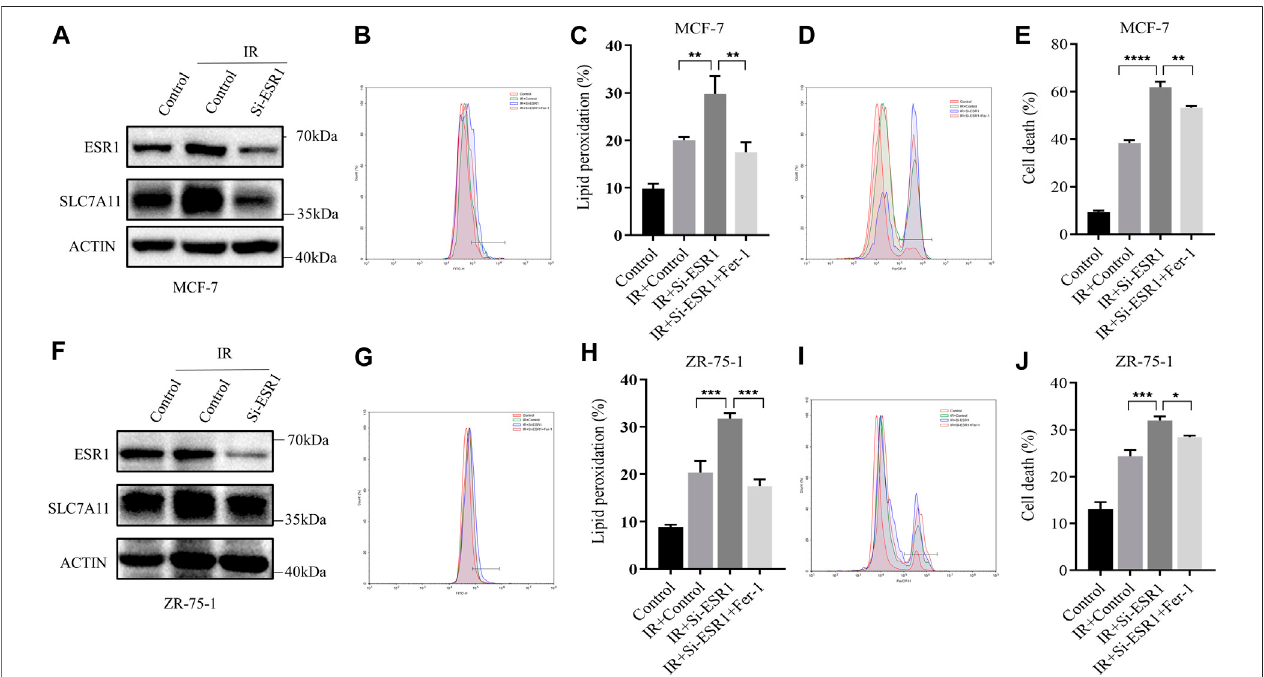
FIGURE 5 | ESR1-SLC7A11 axis is involved in IR-induced ferroptosis. The results of Western blot assay show that ESR1 knockdown inhibited the increase of SLC7A11 induced by IR at 12 h in MCF-7 (A) and ZR-75-1 (F) . (B – E,G – J) Lipid peroxidation and cell death were assessed by fl ow cytometry using C11-BODIPY and trypan blue, respectively. Shown is mean ± SD, n ≥ 3, * p < 0.05; ** p < 0.01; *** p < 0.001; **** p <